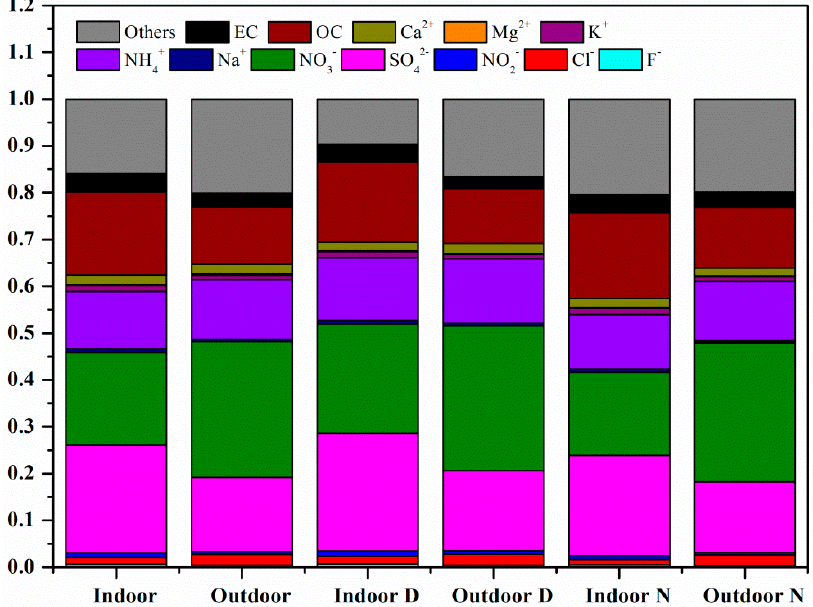
Figure 3. Chemical composition of indoor and outdoor PM 2.5 .